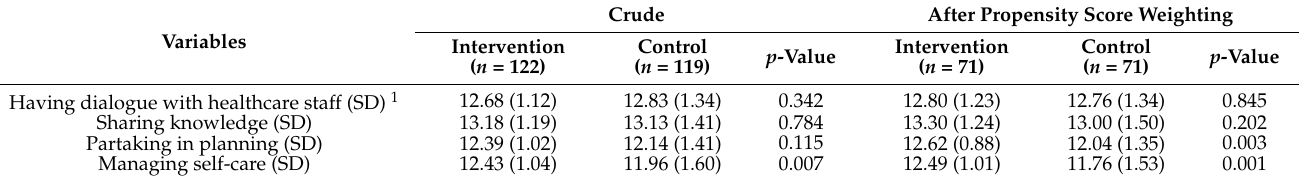
Table 3. Longitudinal difference scores (changes between pretest and posttest) on the four headings of the questionnaire: Description and results of a comparison of groups before and after propensity score